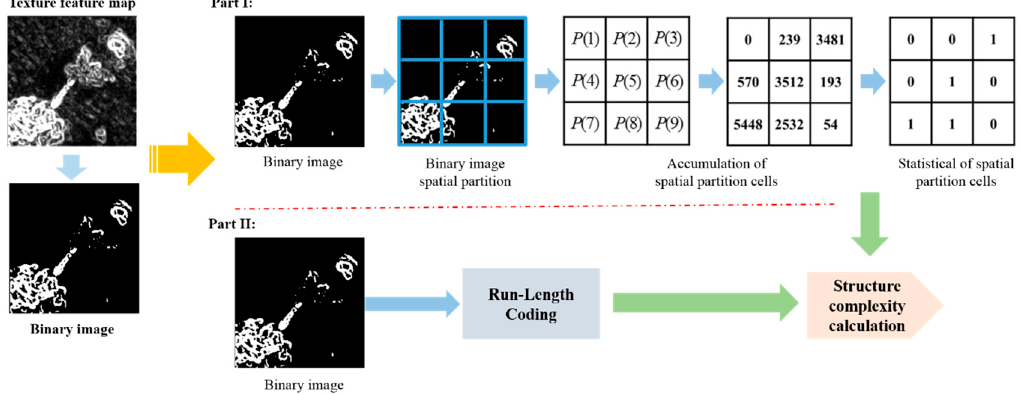
Figure 4. Local scene partition method for scene characteristic classification.